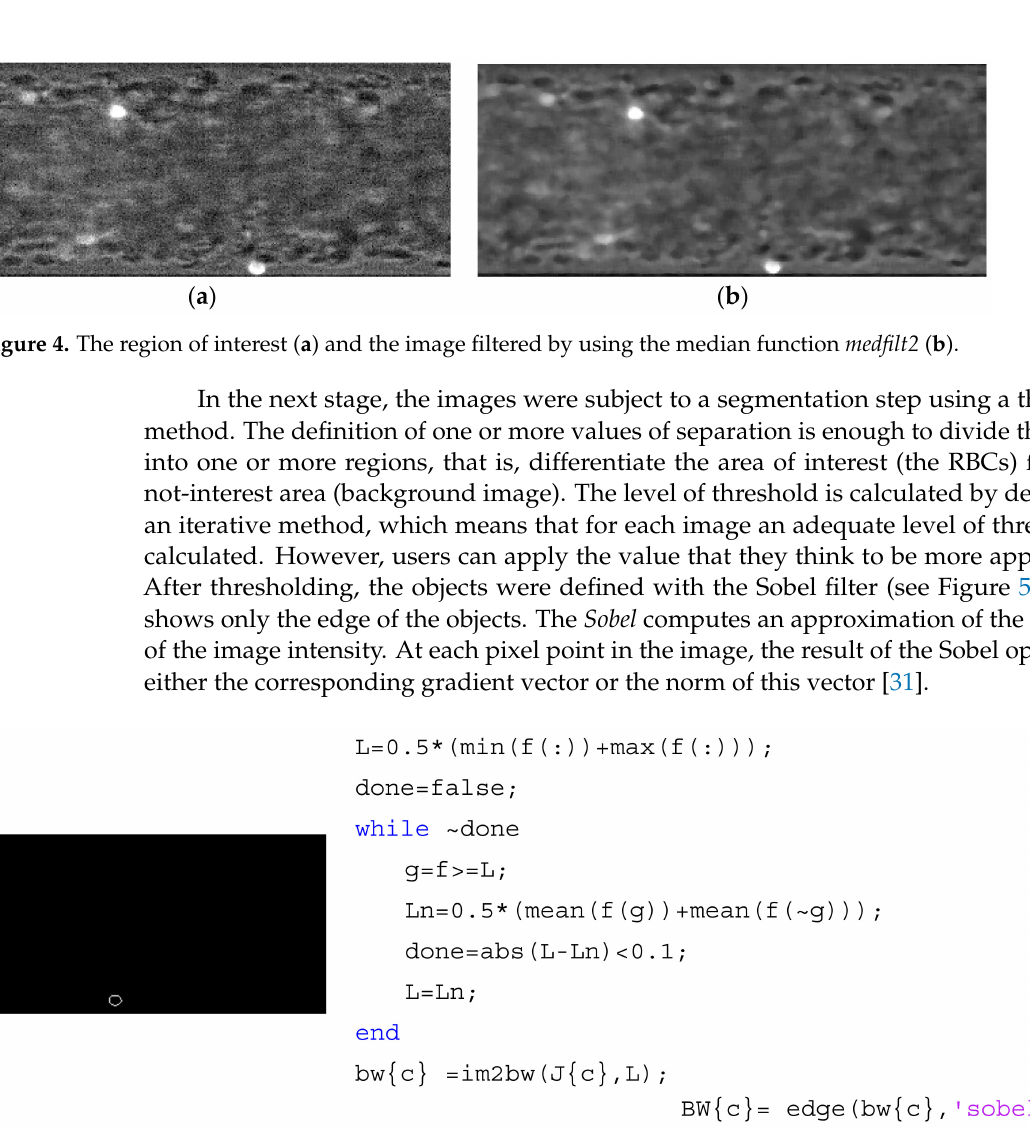
Figure 5. The obtained image of the iterative threshold method and the application of the Sobel filter. After the segmentation processing, the RBCs were tracked and sets of data (and positions) were obtained with the MATLAB function from the image processing toolbox, regionprops [27] (cf. Figure 6). This function measures a set of properties (area, centroid, etc.) for each connected component (RBC) in the binary image.